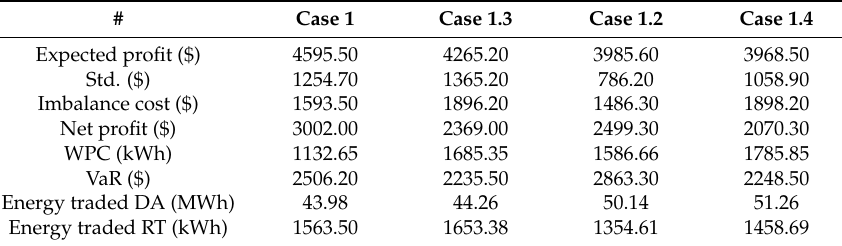
Table 3. Sensitivity analysis for uncoordinated operation.